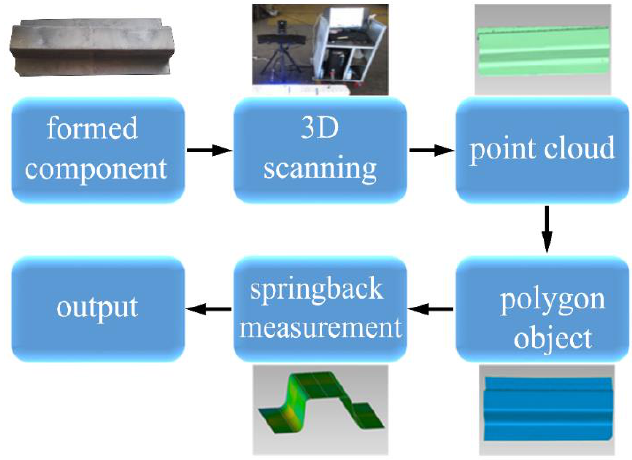
Figure 3. Flowchart of the springback measurement process.